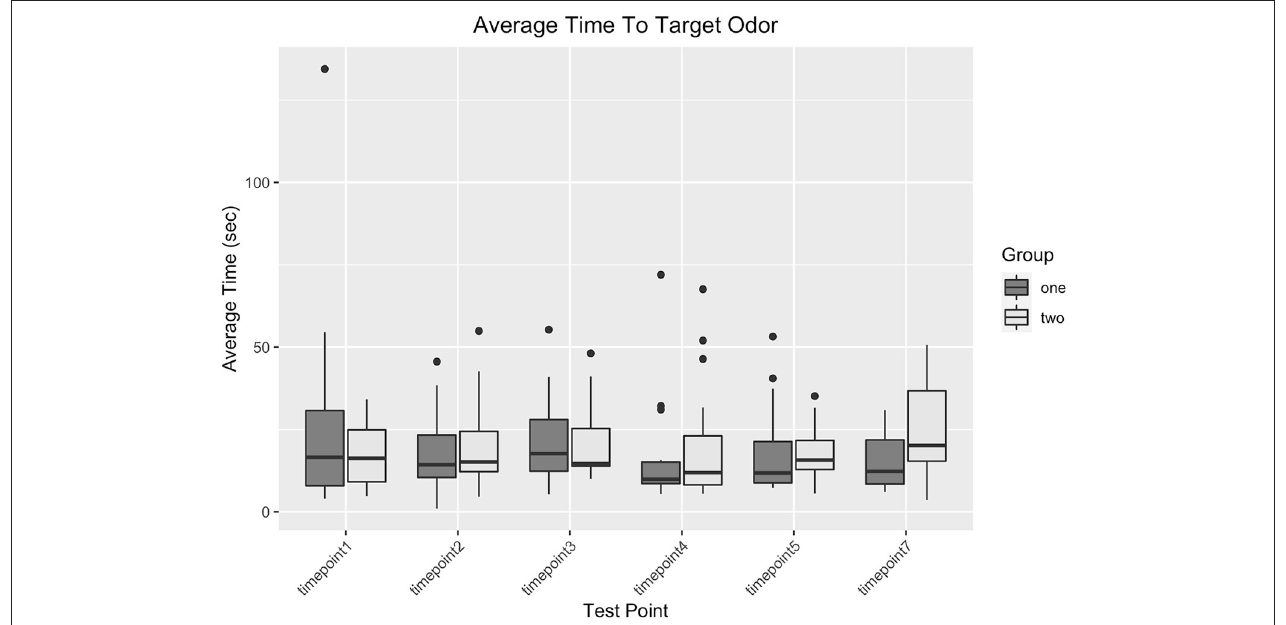
FIGURE 2 | A graph of dogs’ search duration in seconds at each timepoint in the study grouped by the current treatment they were receiving.